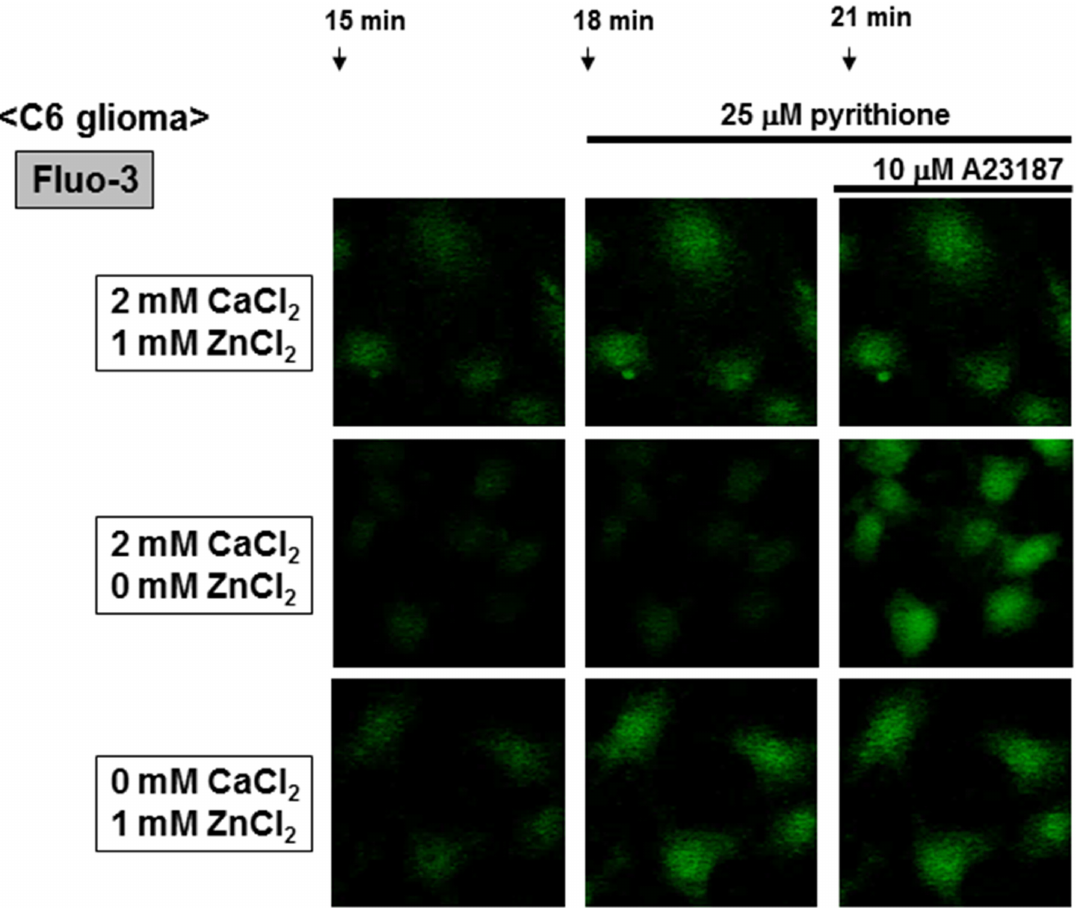
Fig 2. Micrographic pictures of Fluo-3 fluorescence in C6 glioma cells exposed to CaCl 2 and ZnCl 2 in the presence of A23187 and pyrithione. Typical pictures are shown here.